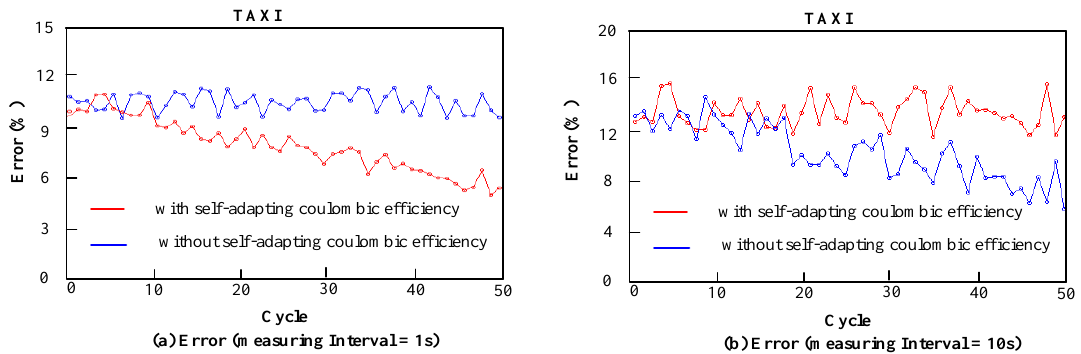
Figure 10. Estimation errors of two different Coulomb counting methods. ( a ) Measuring interval = 1 s; ( b ) Measuring interval = 10 s.